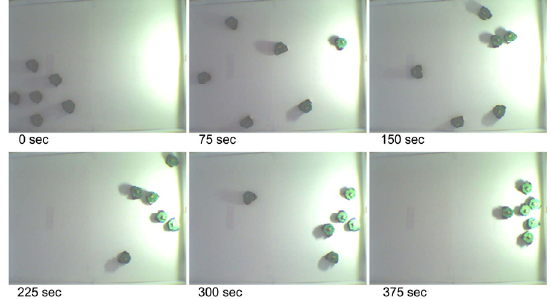
Fig. 10. A group of six AMiRs could find the optimal